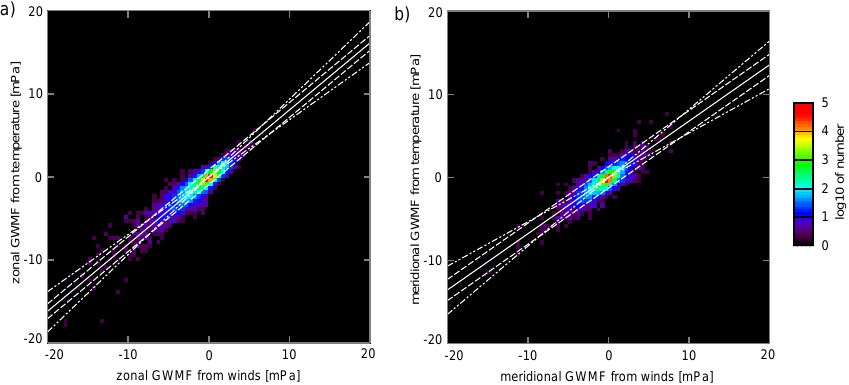
Fig. 11. Logarithmic point density of (a) zonal and (b) meridional GWMF inside all fitting-cubes at 25 km alti- tude. On the x-axis the value determined from winds, on the y-axis the values determined from temperatures are provided. The white lines show (solid) the linear regression (dashed) the width in the center of the distribution and (dashed dotted) the relative width of the distribution. Black color indicates no wave events in the respective bin.